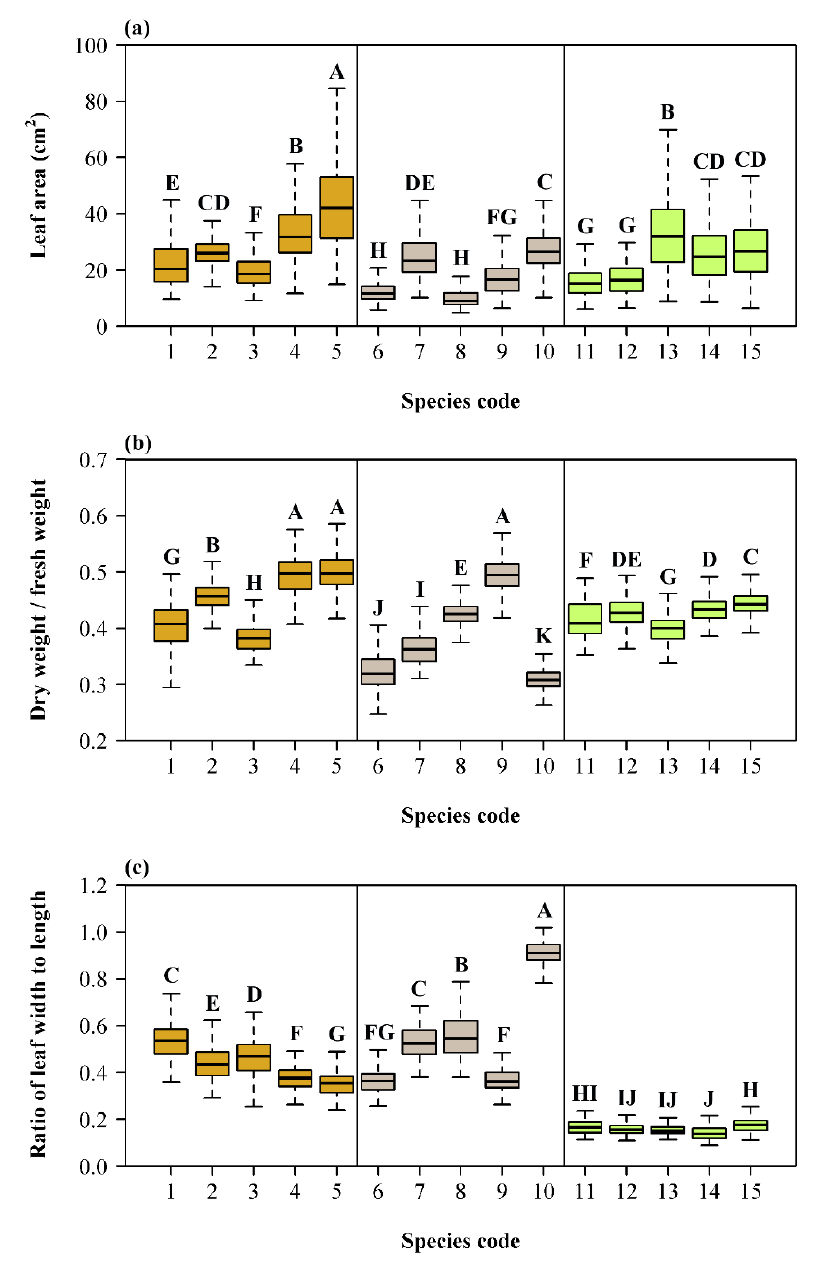
Figure 4. Boxplots of leaf area ( a ), the ratio of leaf dry weight to fresh weight ( b ), and the ratio of leaf width to length ( c ). The letters above the upper whiskers are used to show the significance of the difference between any two species. Species sharing the same letter indicate that there is no significant difference in the measure of interest. The scientific names associated with the corresponding species codes can be found in Table 1. The three colors from left to right represent Lauraceae, Oleaceae, and Bambusoideae.